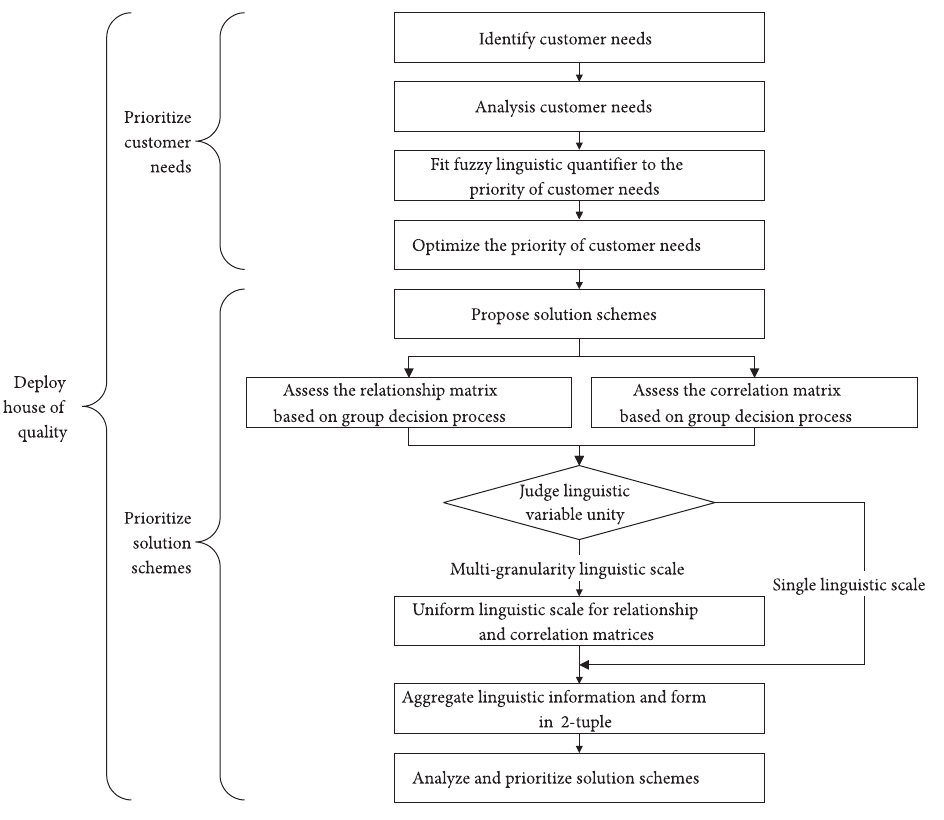
Fig. 5. The flow chart of the